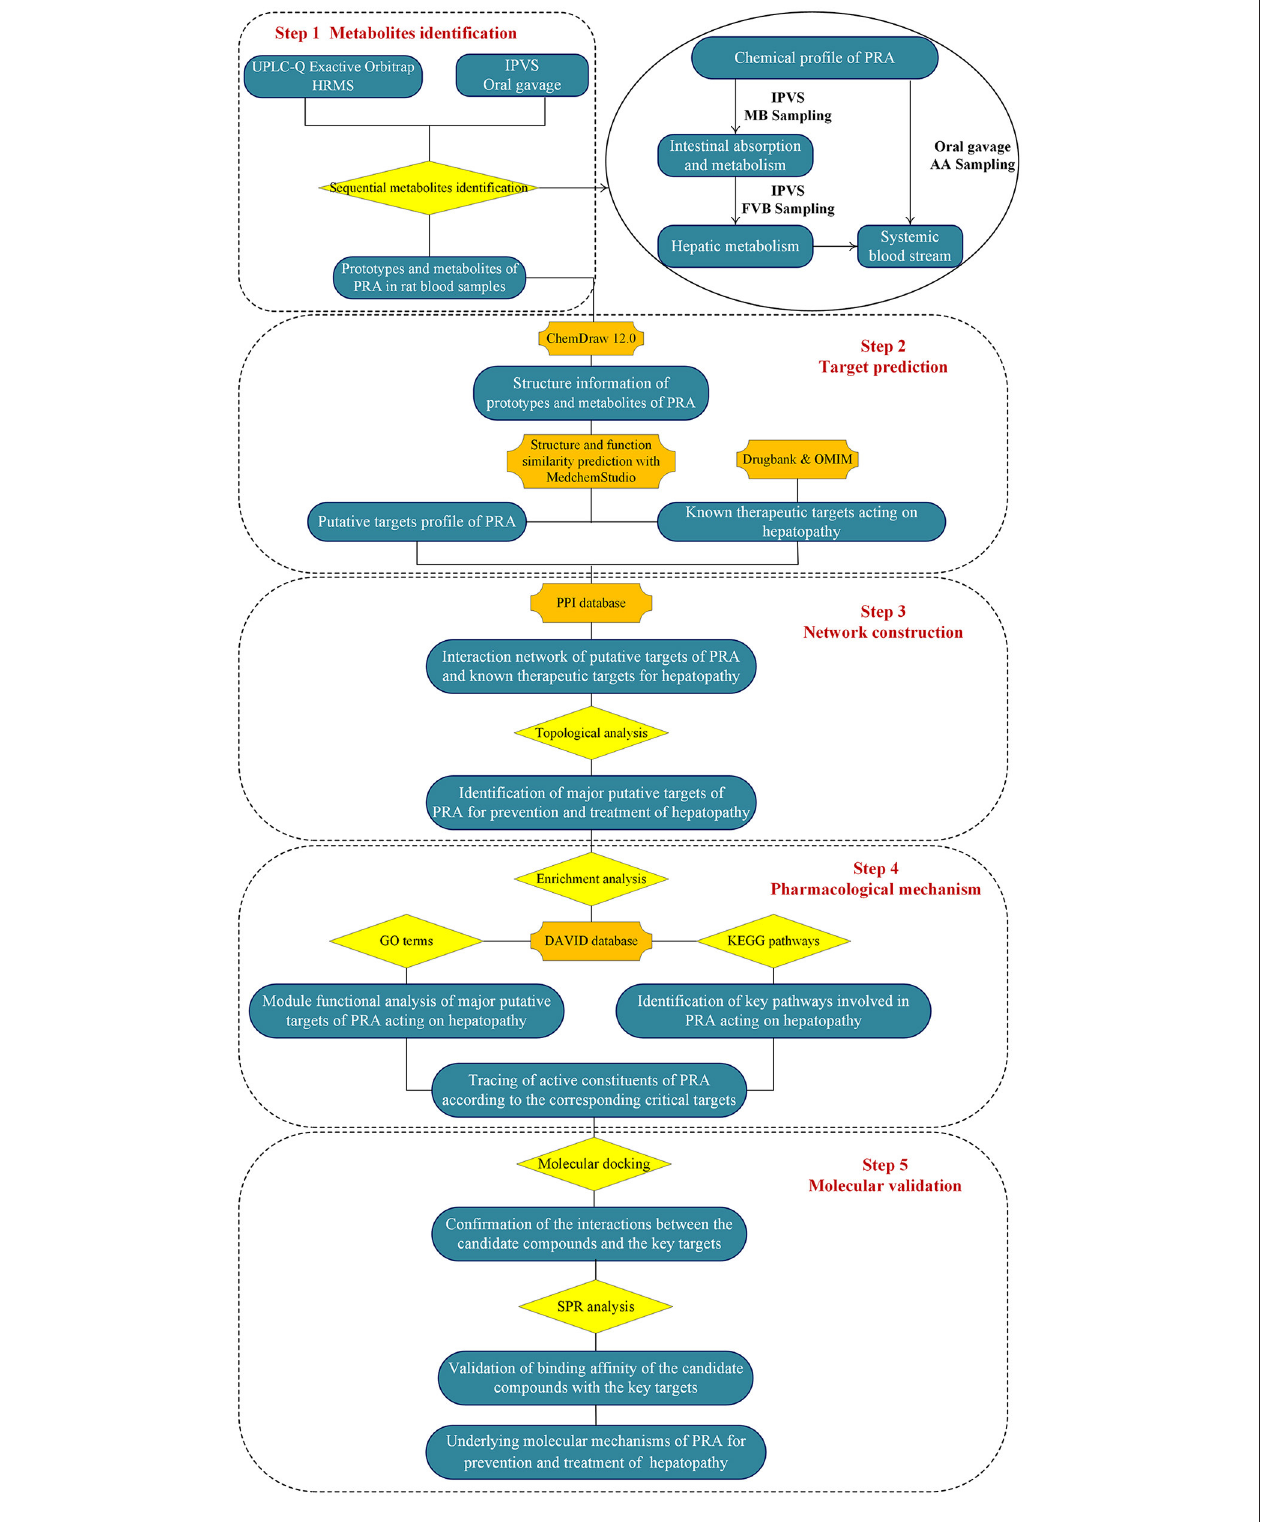
FIGURE 1 | Flowchart of the study